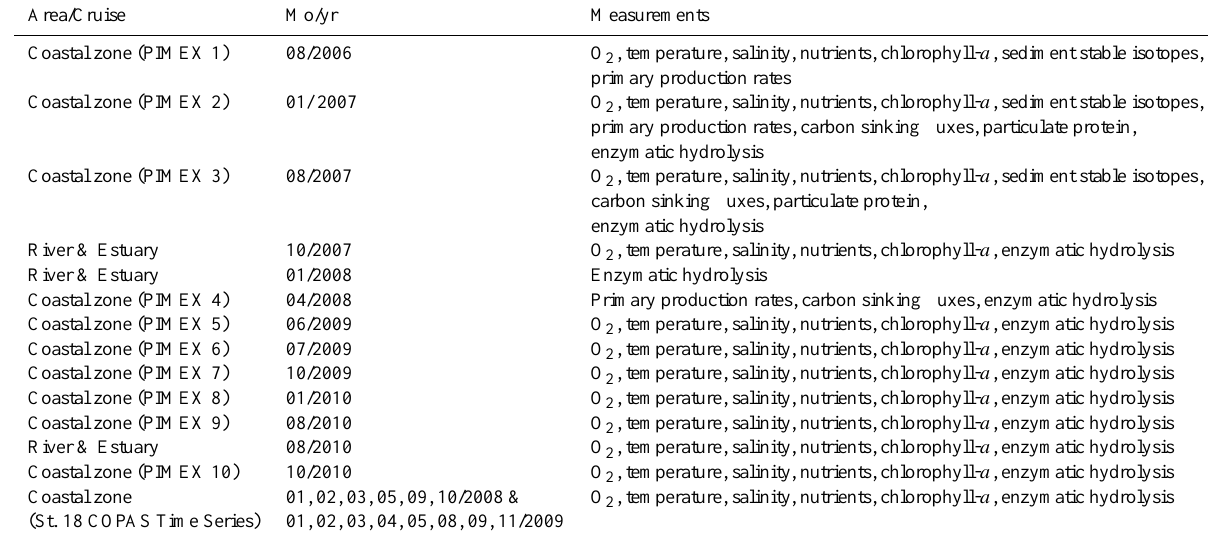
Table 1. Sampling cruises and samples collected from 2006 to 2010 in the study